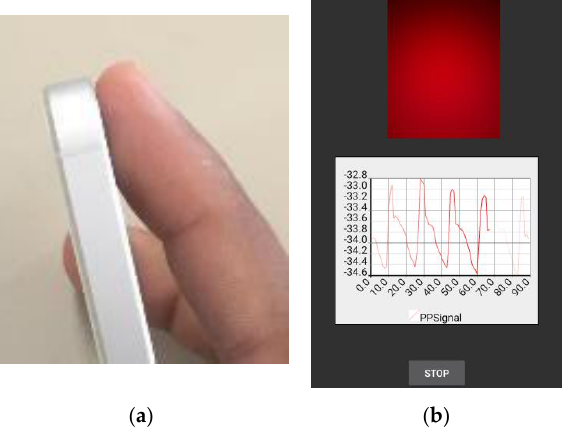
Figure 1. Our developed smartphone-based heart rate detection application: ( a ) fingertip placement; and ( b ) graphic user interface (GUI) of our developed application. and ( b ) graphic user interface (GUI) of our developed